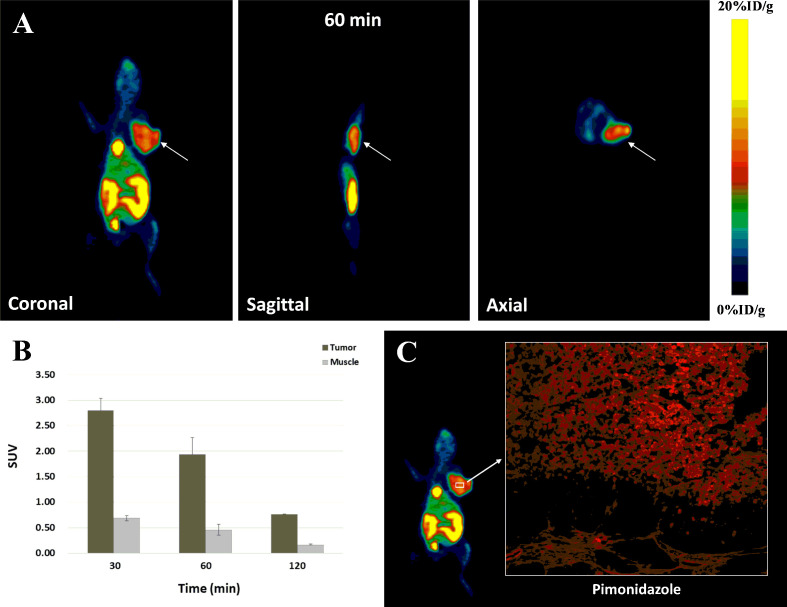

(A) MicroPET images of Al18F-NOTA-NI for tumor-bearing mice at 60 min after radiotracer administration (white arrows indicate tumors). (B) ROI-derived %ID/g for tumor and muscle, respectively (n = 4 per time point). (C) Immunofluorescence images of Pimonidazole in tissue sections of xenograft tumors (red).